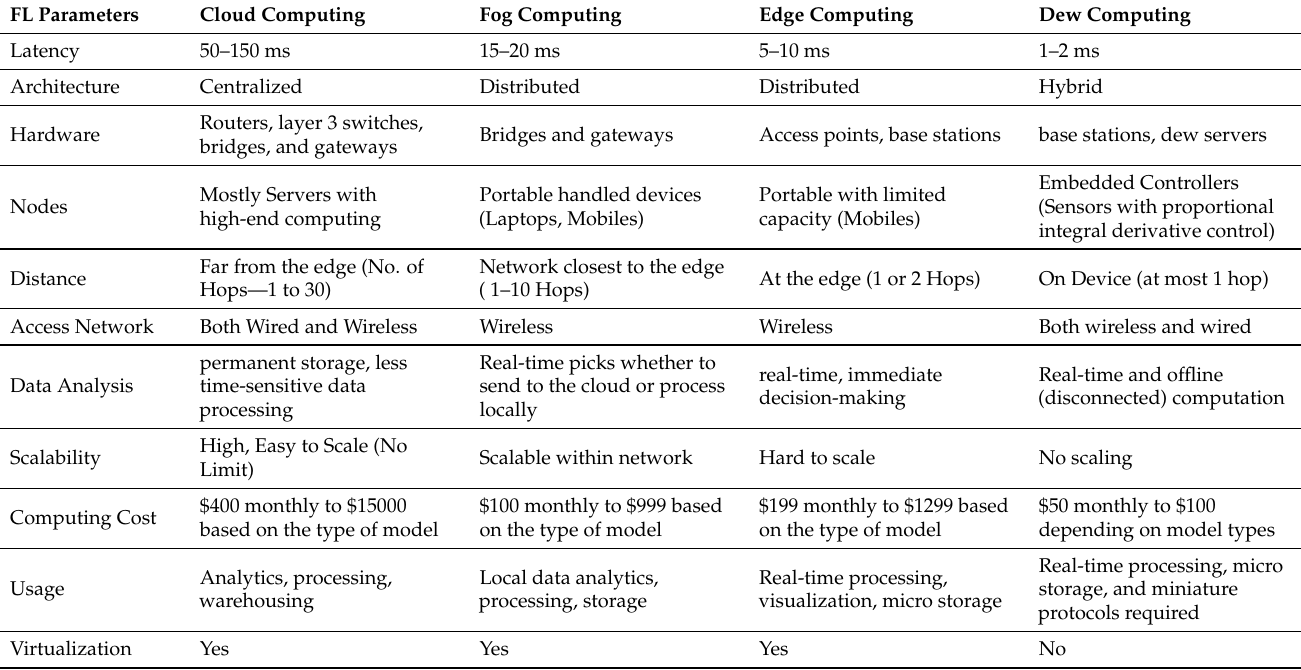
Table 6. A comparative analysis of IoMT devices at varying levels of computing nodes (Cloud, Fog, Edge, and